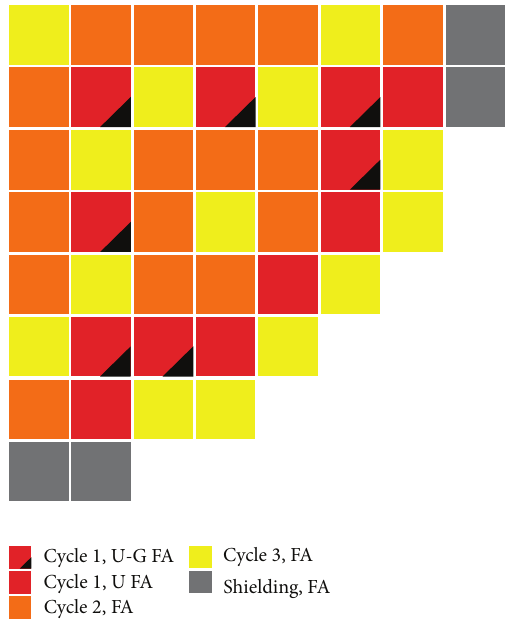
Figure 3: The figure shows the lower right corner of the standard core loading pattern.